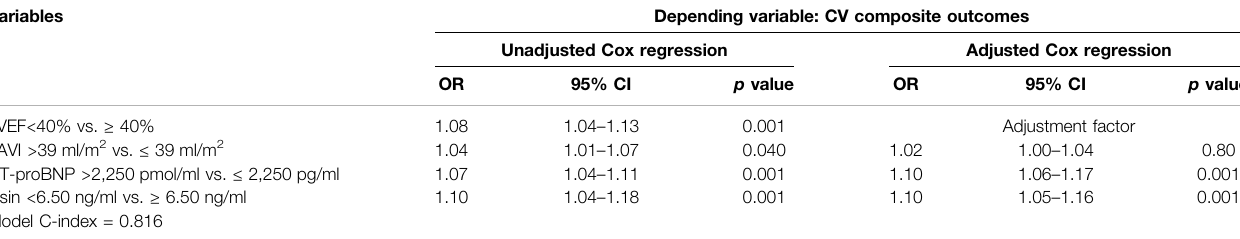
TABLE 3 | Multivariate Cox regression analysis of determinant variables affecting CV composite outcomes in HF patients with T2DM. Variables Depending variable: CV composite outcomes Unadjusted Cox regression Adjusted Cox